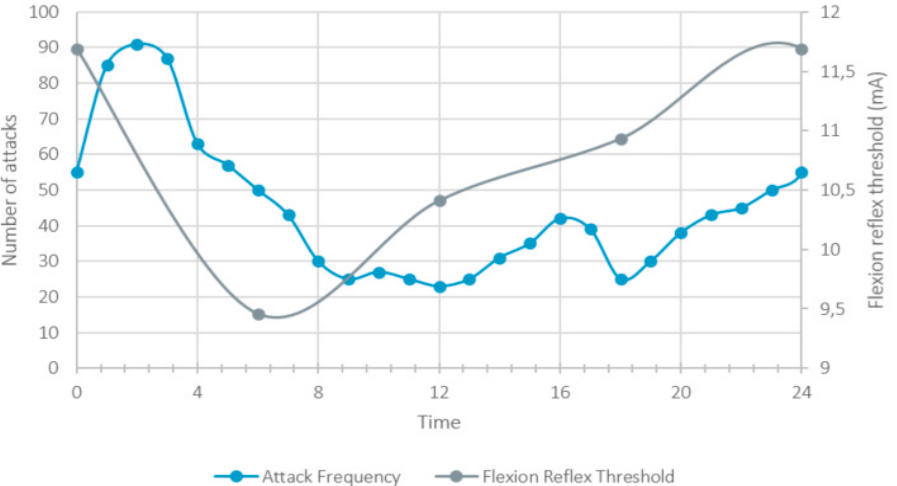
Figure 2. Correlation between time and attack frequency as well as time and the flexion reflex threshold in patients with episodic cluster headache; the The left vertical axis refers to the number of attacks in a sample of cluster headache patients,; the right refers to the flexion reflex threshold (mA). Data derived from Nappi et al. [36] and Barloese et al. [5].